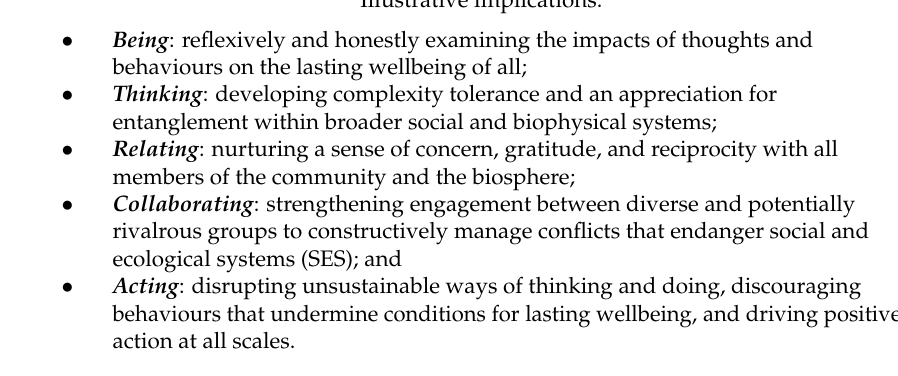
Table 3 outlines the basic requirements for inner-outer sustainability progress that we have identified as essential for assessment purposes and presents them as criteria for evaluating current and proposed activities and initiatives. It also sets out illustrative implications for the evaluation of inner sustainability interventions. Table 3. Basic inner-outer sustainability assessment